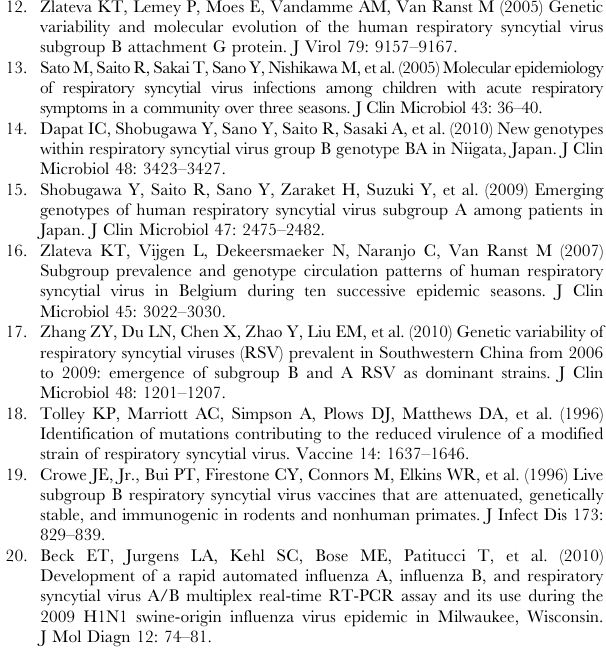
Figure 5. Entropy plot and graphical representations of the RSV A and B genomes . The entropy data is represented by the vertical black bars with the scale for the y-axis being from 0 to 1. The higher the bar the more variation (mutations, insertions, or deletions) at that position in the genome alignments. The dark grey bars represent the coding regions. The M2-1 and M2-2 coding regions overlap so are represented by a single bar. The light grey regions correspond to the 5 9 and 3 9 NCRs of each gene and include the GS and GE signals. The white regions correspond to the non- genic regions of the genome. Above the plots, each gene is labeled and there is a bar that runs from the beginning to end of each gene.